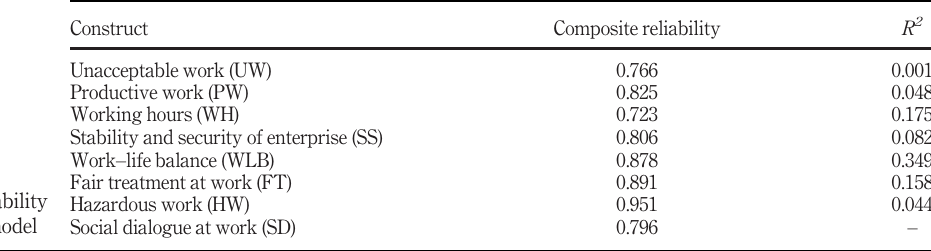
Table I. Composite reliability and R 2 of the